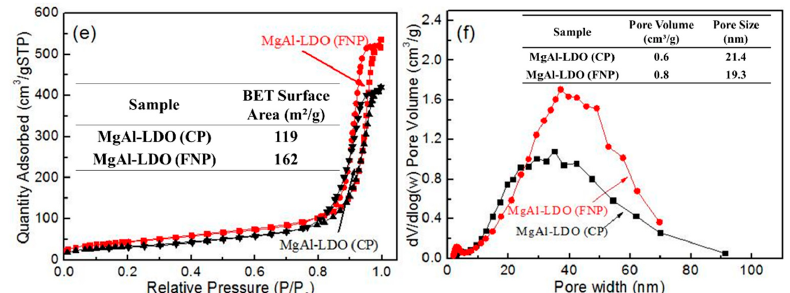
Figure 3. Transmission electron microscopy (TEM) and high-resolution TEM (HRTEM) images of ( a , c ) MgAl-LDO (CP); ( b , d ) MgAl-LDO (FNP); atomic force microscopy (AFM) images of ( c ) MgAl-LDO; (CP) and ( d ) MgAl-LDO (FNP). ( e ) N 2 adsorption-desorption isotherm. ( f ) Pore size distribution of Ni/MgAl-LDO (CP) and Ni/MgAl-LDO (FNP).